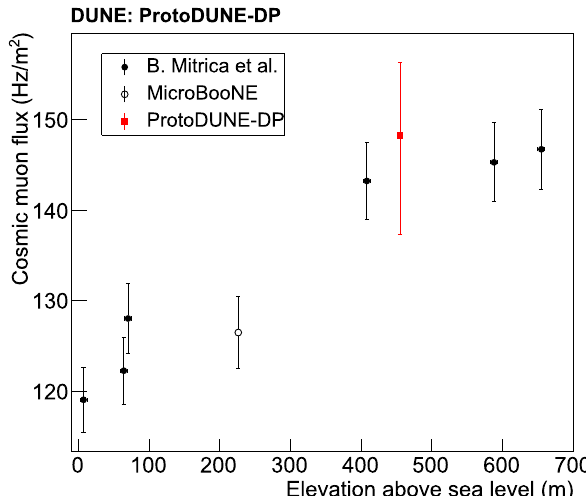
Fig. 21 Cosmic muon flux determined in ProtoDUNE-DP at CERN at 455m above mean sea level (red square) compared to the measurements reported in [52] (filled black dots) and [53] (open black dot) Table 8 Total S1 charge per cosmic muon (sum of all PMTs detecting a S1 signal) and observed light yield (average value from events and maximum value reached in an event) for two trigger modes. All the values obtained from data Trigger PMTs S1 charge per muon